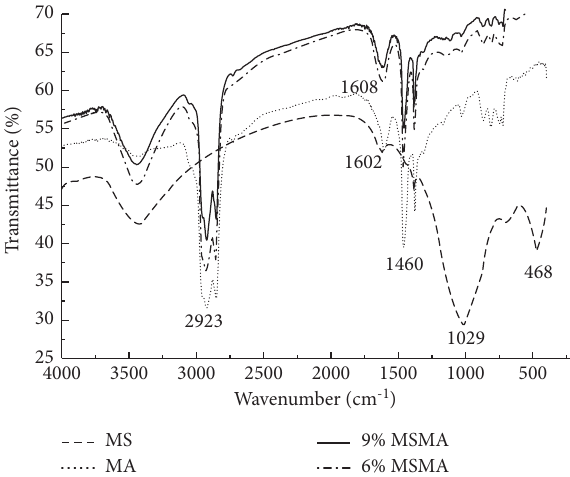
Figure 2: Infrared spectra of the EMR and